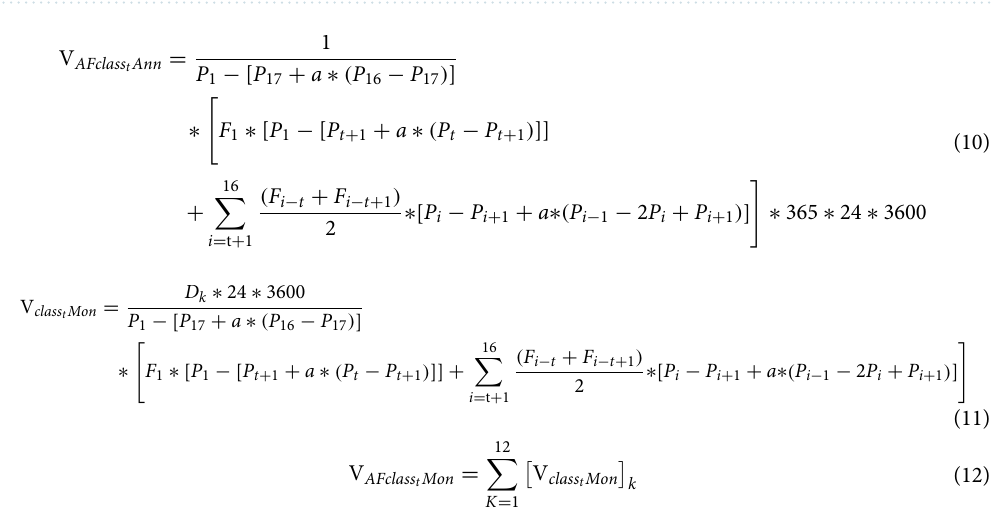
Figure 3. Comparison of the EFR allocated to each of the environmental management classes from this new approach (on the left) with the conventional FDCS methods (on the